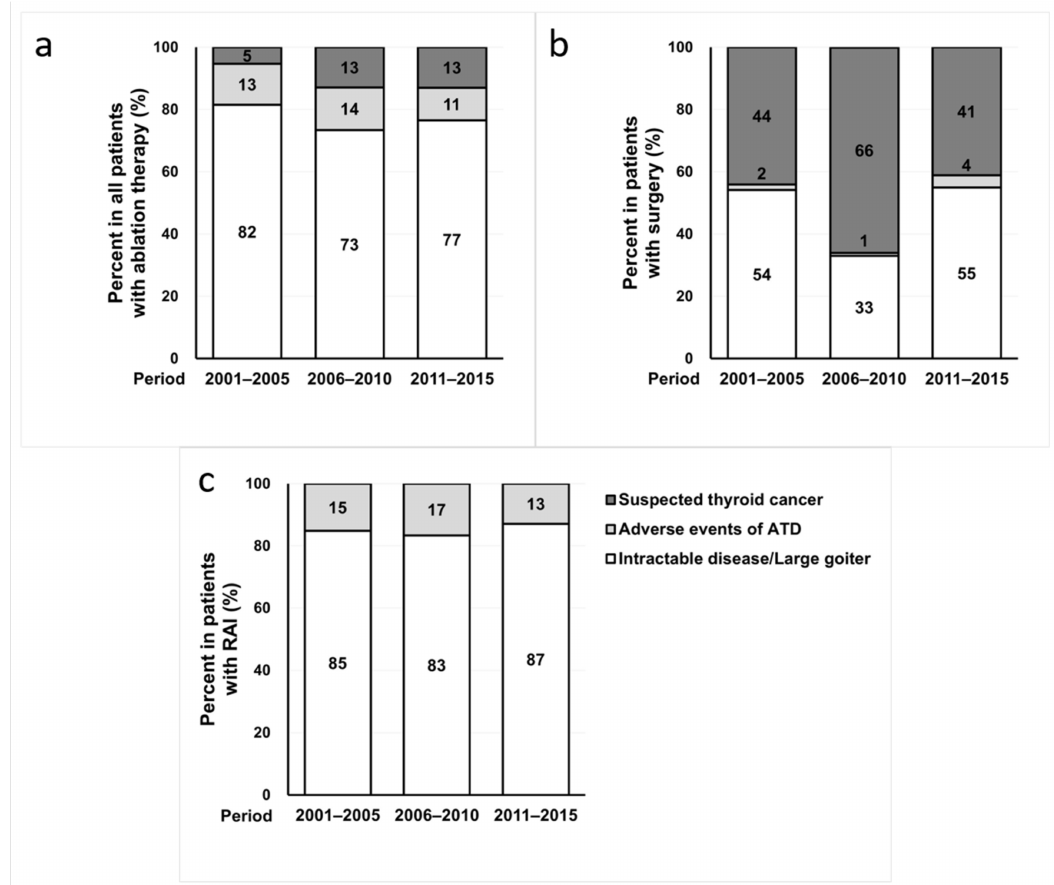
Figure 2. Changes in the reason for ablation therapy for Graves’ disease over time. ( a ) All patients, n = 10,991. ( b ) Patients who received surgery, n = 267. ( c ) Patients who received RAI therapy, n = 1090.